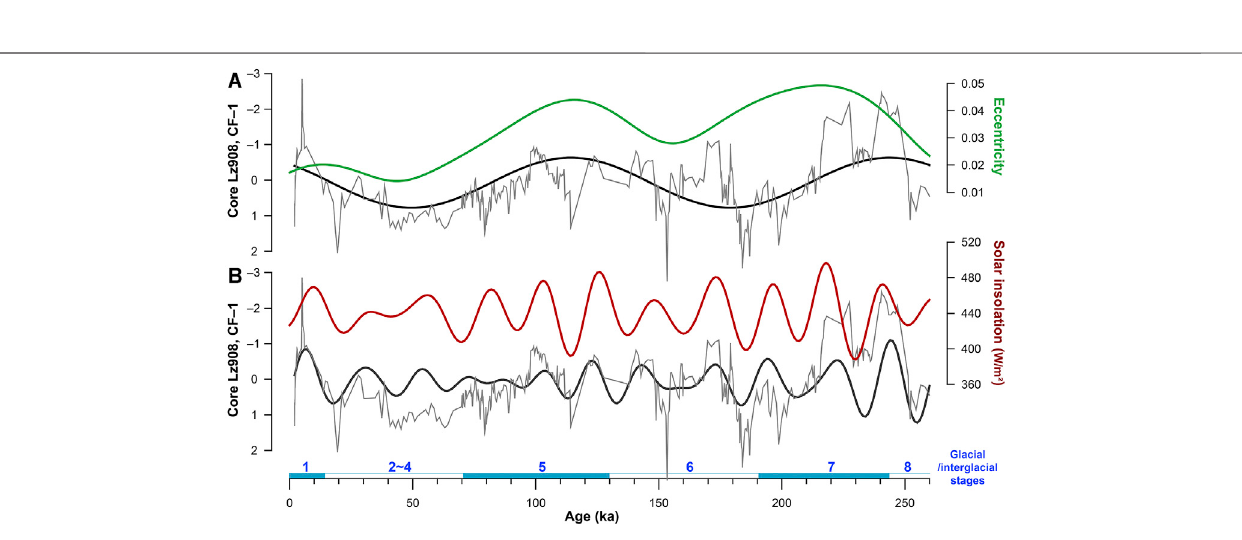
Frontiers in Earth Science |